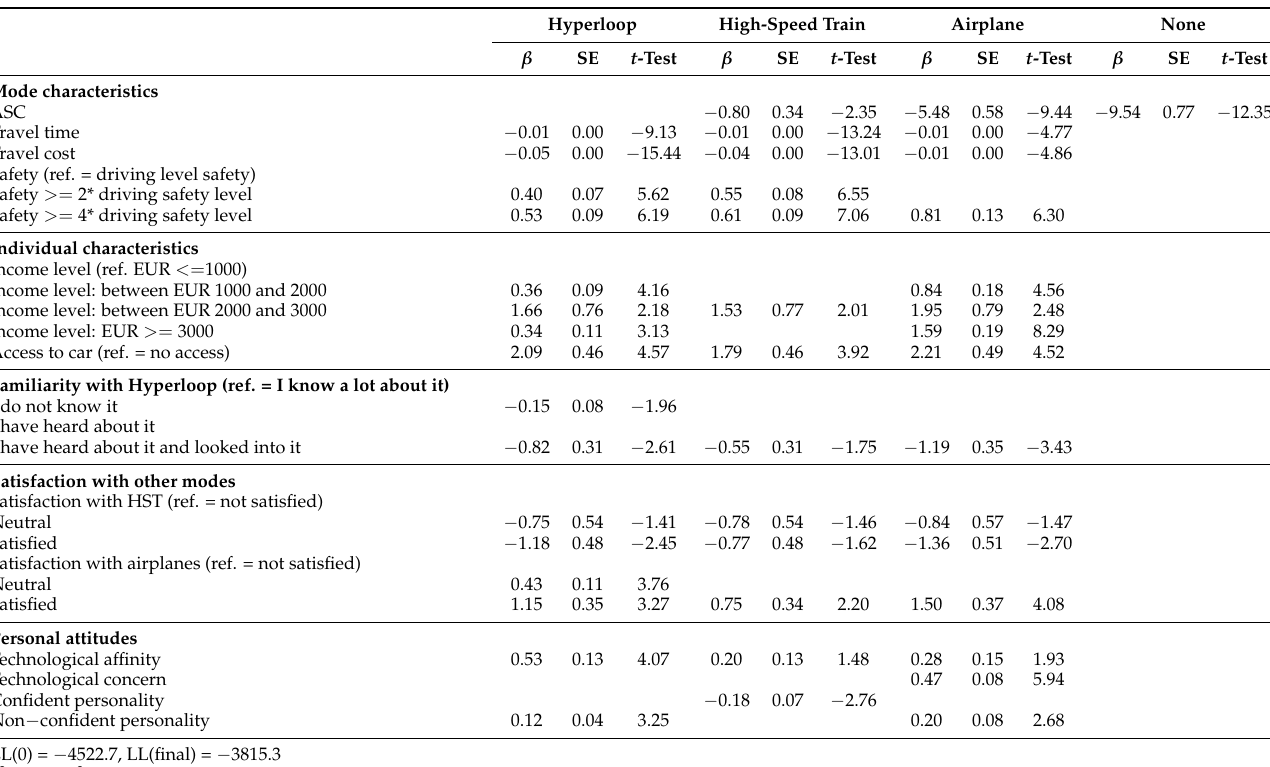
Table 6. Multinomial logit model results (Hyperloop vs. other